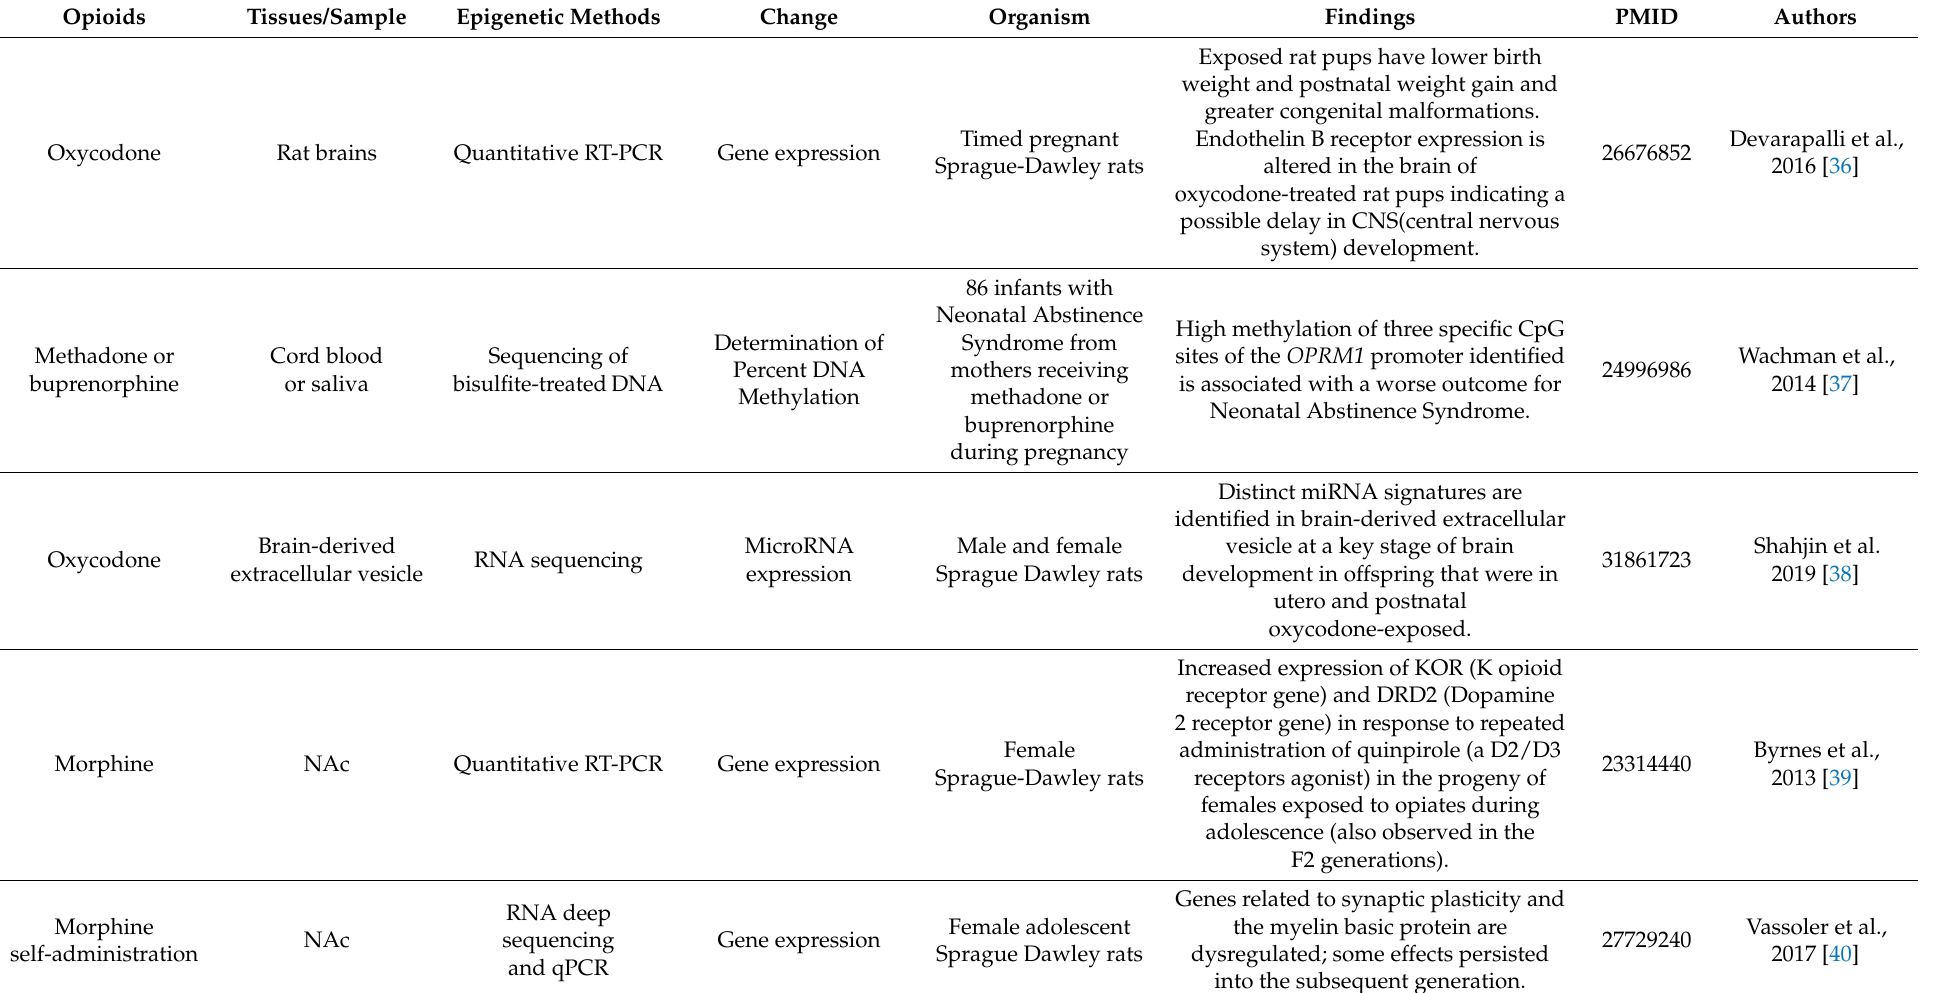
Table 3. Intergenerational/transgenerational prescribed opioid